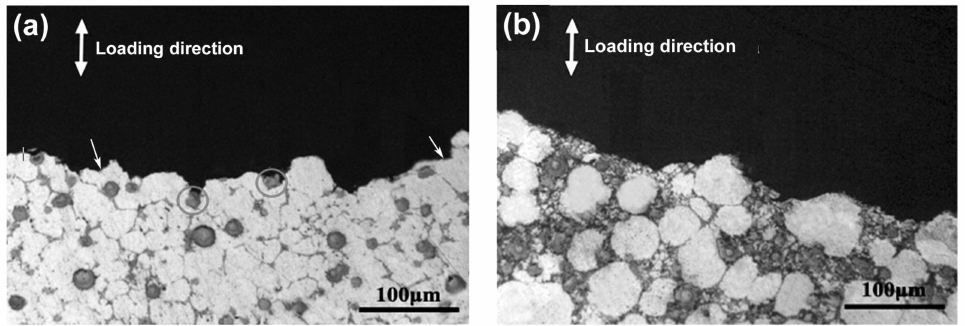
Figure 10. Side-views of fracture surfaces of the composites thixoformed at reheating temperatures of ( a ) 590 ◦ C and ( b ) 610 ◦